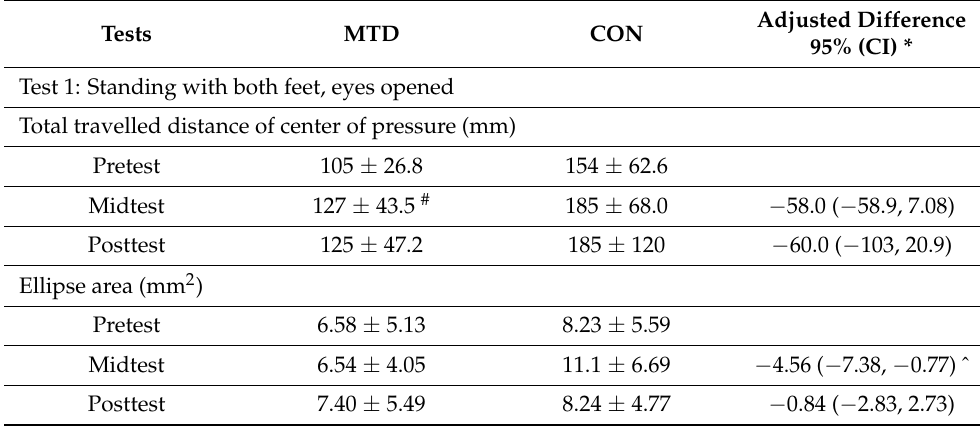
Table 3. Between and within-group differences in postural control-related